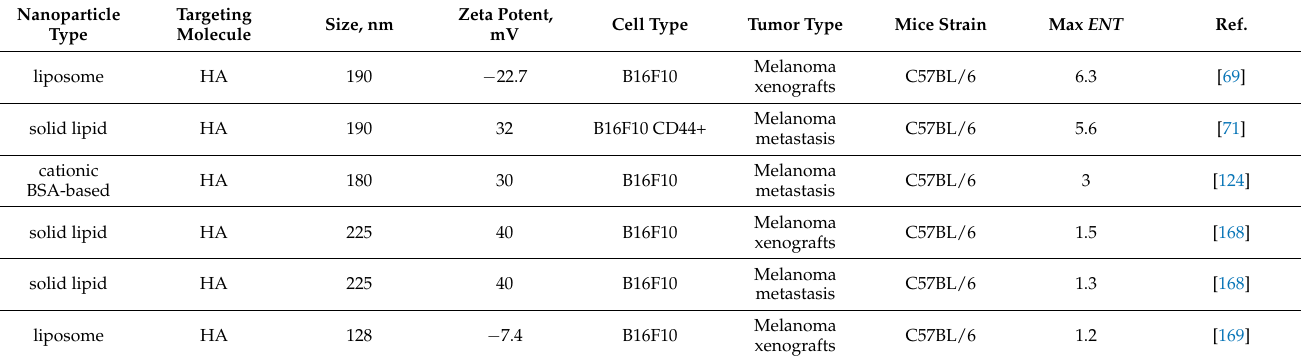
Table 3. Nanoparticles targeted by the HA in the B16F10 melanoma xenografts. The data are sorted by the maximum ENT . Nanoparticle Type